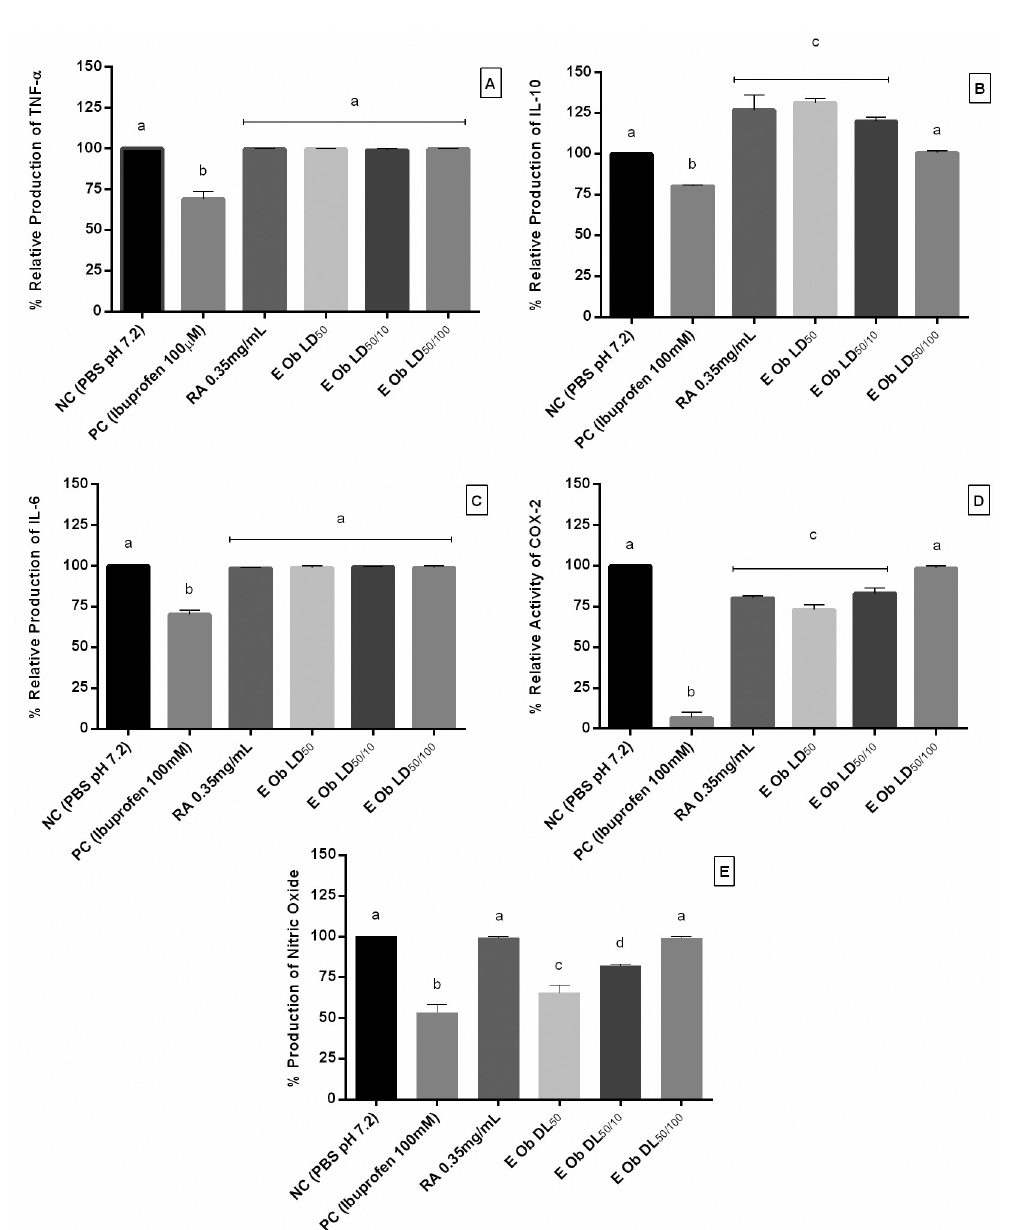
FIGURE 4 - Effects of O. basilicum extract in inflammatory parameters of human leukocytes in culture subject to dextran solution. All the results are presented as percentage in relation to the negative control. In A: tumoral necrose factor-α (TNF-α); B; interleukine-10 (IL-10); C: interleukine-6 (IL-6); D: Ciclooxigenase type 2 activity (COX2 activity); E: nitric oxide (NO) production NC: negative control; PC: positive control; RA: rosmarinic acid; LD50: concentration equals to LD50 (35.44 µg/mL); LD50/10: 10 times less the concentration of LD50 (3.544 µg/mL); LD50/100: One hundred times less the concentration of LD50 (0.3544 µg/mL). Data are expressed as mean ± S.D. Results were confirmed by an experiment that was repeated three times. Different letters represent statistically different results among columns (p <